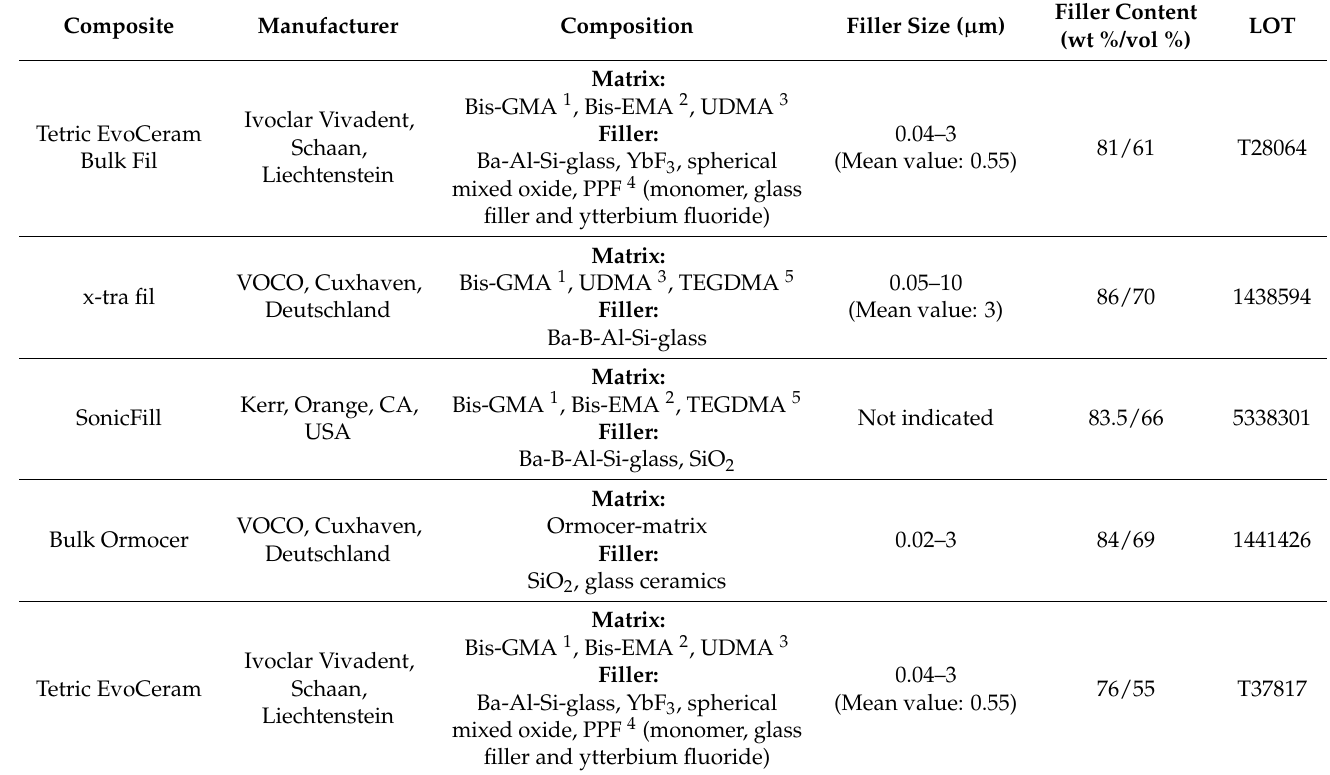
Table 1. Manufacturers’ information on the composite materials used in this